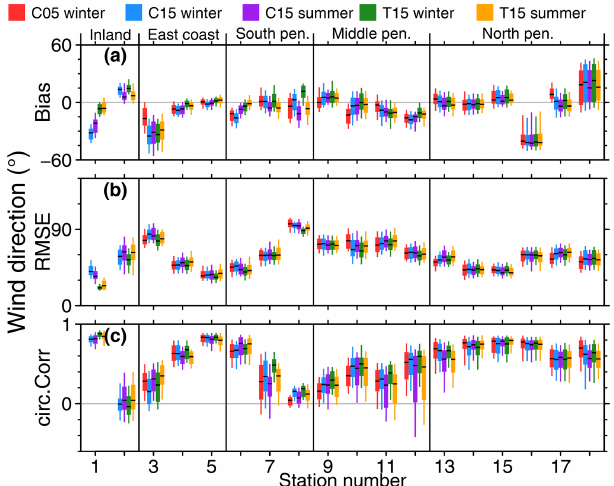
Figure 7. CCLM (a) 2m temperature bias, (b) RMSE, and (c) cor- relation for C05, C15, and T15 for different surface stations (see Table 4). Boxes indicate the 25% / 75% quantiles, and whiskers in- dicate the 10% / 90% quantiles; the median is indicated by a black line inside the box. Statistics (bias, RMSE, and correlation) are cal- culated for every month.